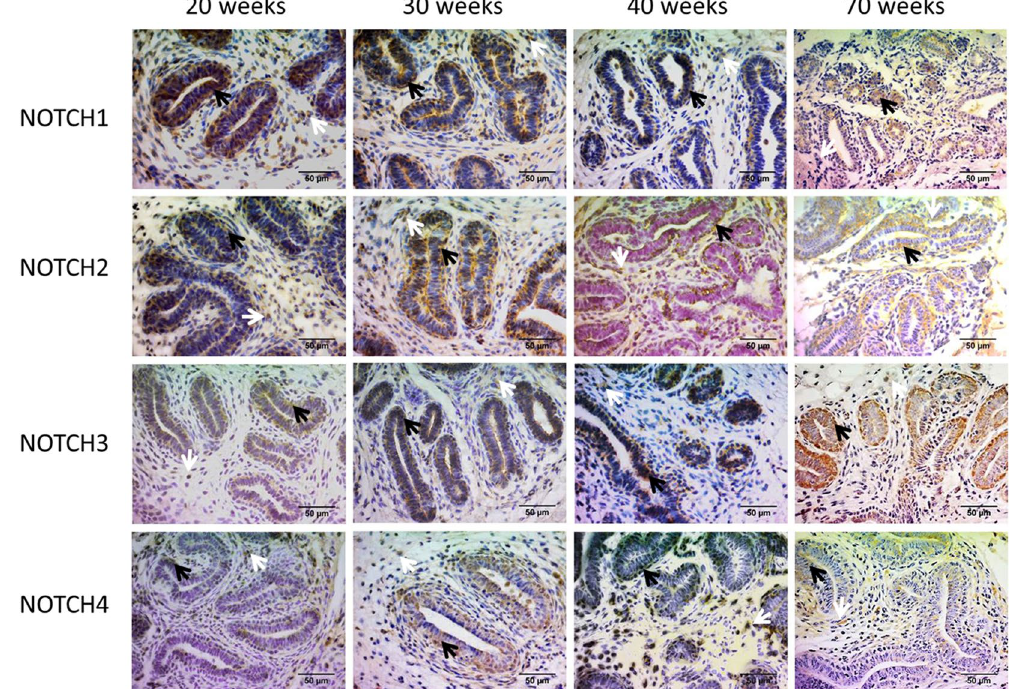
Figure 1. Representative images of immunohistochemical labeling of mammary gland biopsy samples, for the four NOTCH paralogues at 20, 30, 40 and 70 weeks of age. Notch labelling is evidenced in stromal cells (white arrows) and in epithelial and myoepithelial cells of the parenchyma (black